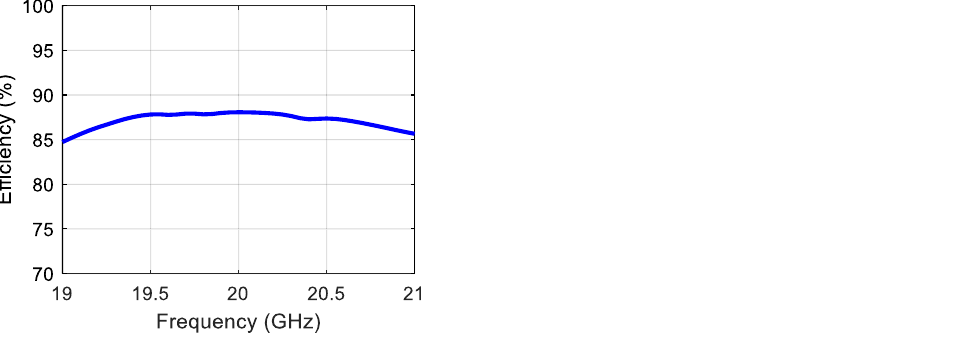
Figure 27. Calculated radiation